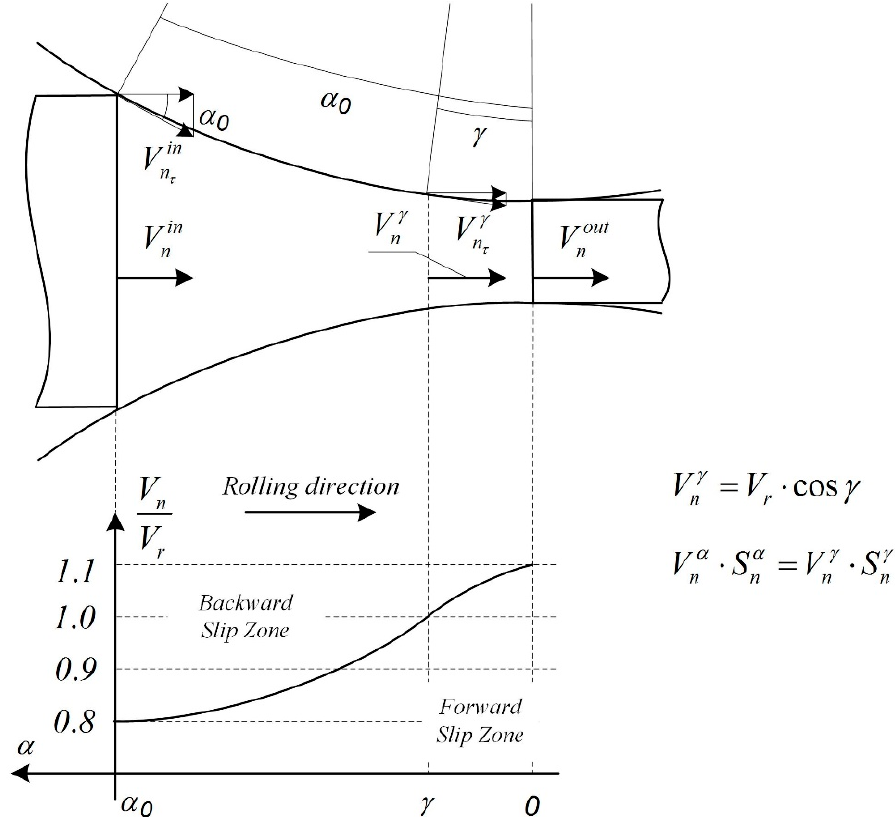
Figure 4. Slip on the feed surface in the uniform deformation zone.